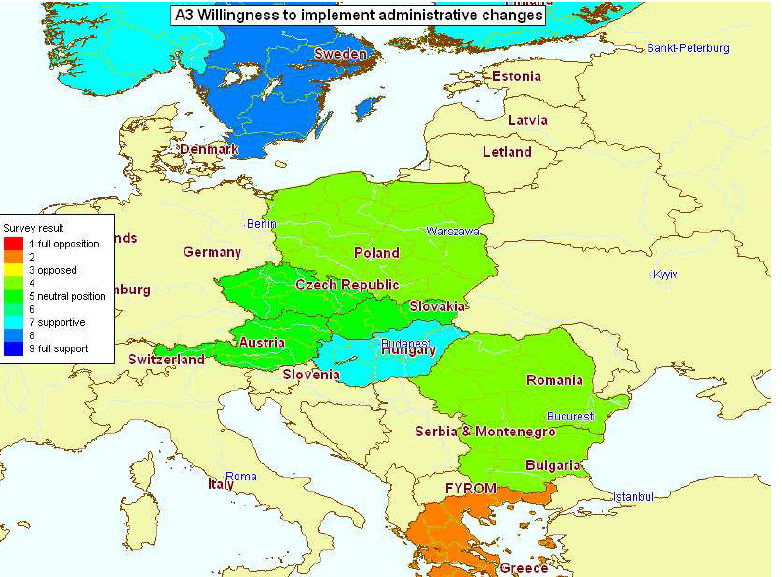
Figure 3. Thematic map for interoperability condition A3 (Willingness of the national rail regulator to implement administrative